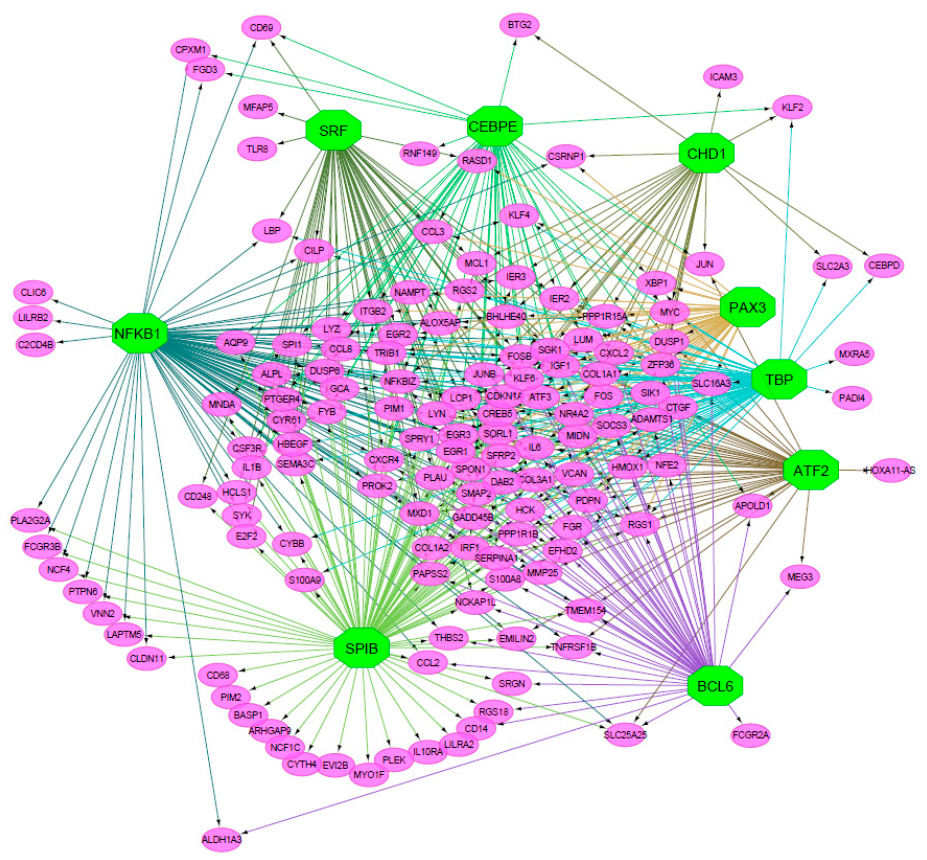
Figure 2. Gene regulatory network. The network shows the connectivity between candidate transcription factors (source nodes; green hexagons) and differentially expressed (DE) genes (target nodes; pink ovals). Edge color refers to clusters of DE genes based on the connections to a specific TF.